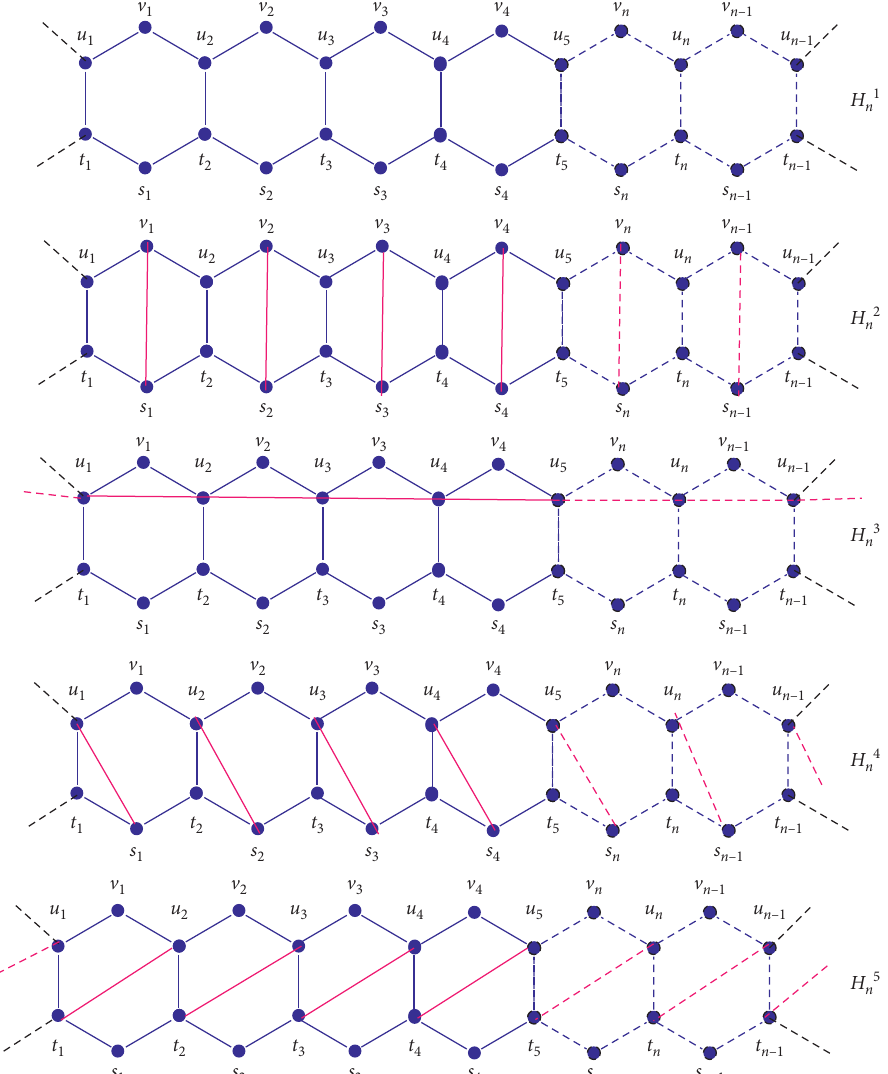
Figure 3: Rotationally symmetric hexagonal planar graphs with 2 and 3